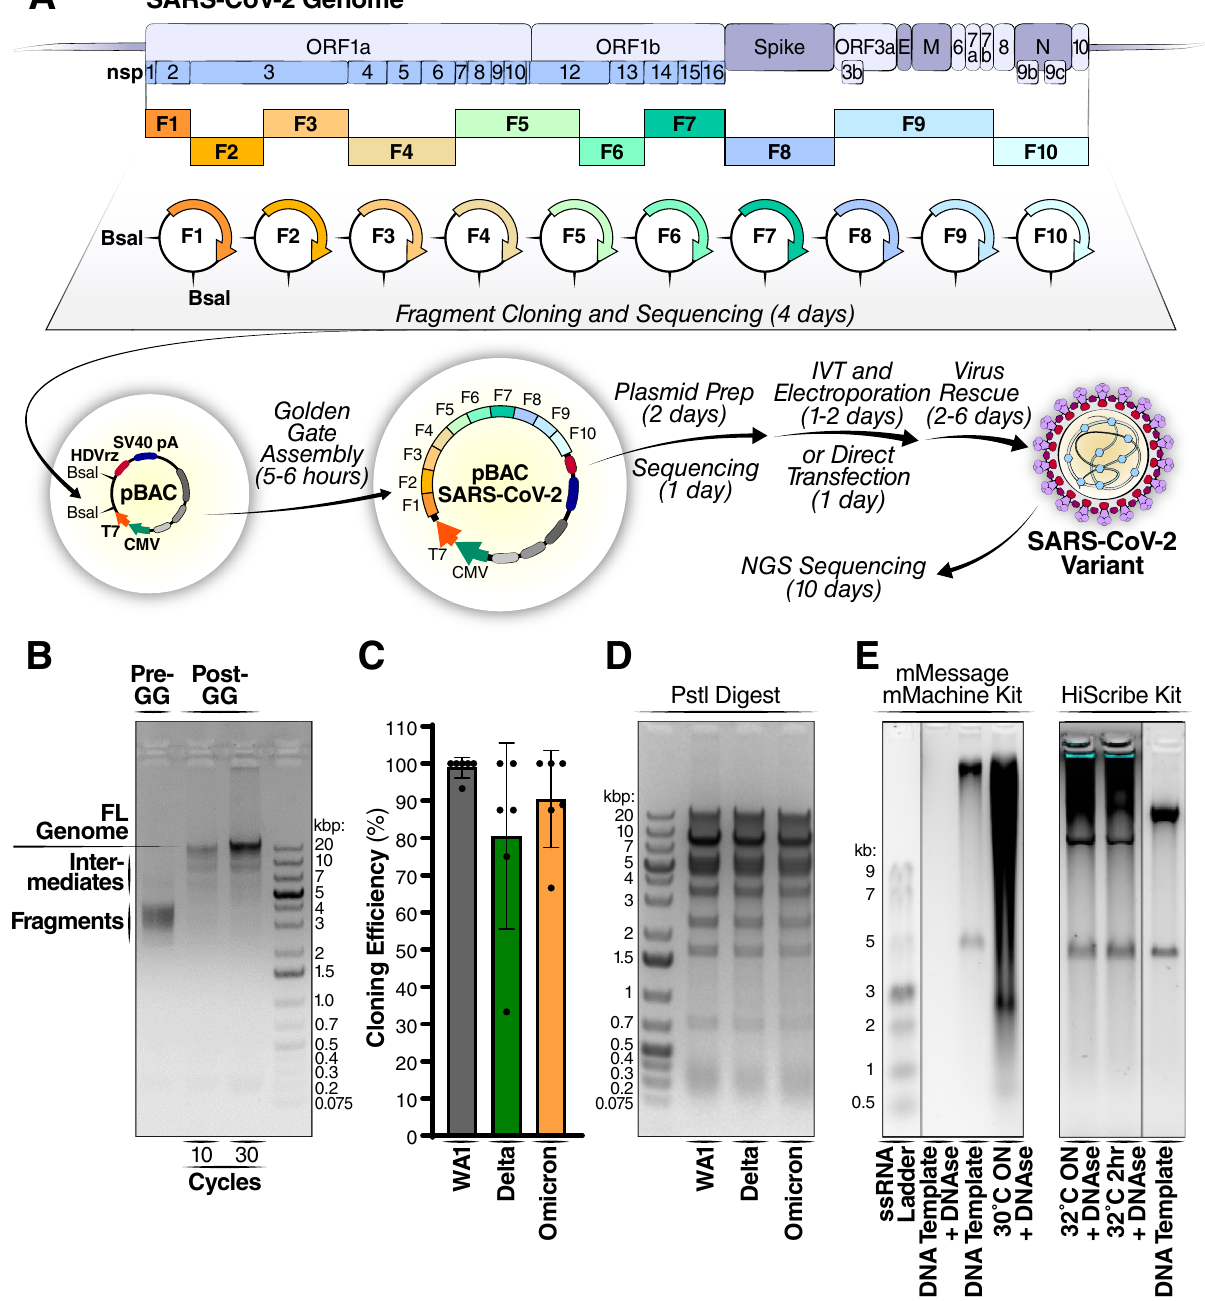
Fig. 1 | Golden gate assembly enables rapid cloning of SARS-CoV-2 variants. A Schematic of cloning methodology and generation of infectious clones. The viral genome was rationally divided into 10 fragments and assembled into a bacterial arti fi cial chromosome (BAC) vector containing T7 and cytomegalo- virus (CMV) promoters, hepatitis delta virus ribozyme (HDVrz), and simian virus 40 (SV40) polyA sequence. The assembled vector was then directly transfected into cells or fi rst in vitro transcribed into RNA, followed by elec- troporation into cells to generate SARS-CoV-2 variants. The estimated time required for each step is indicated in parentheses. IVT, in vitro transcription. The Electroporation image was created with Biorender. B Agarose gel elec- trophoresis of Golden Gate (GG) assembly of the 10 fragments. The gel is representative of 3 independent assembly reactions. C Cloning ef fi ciency of